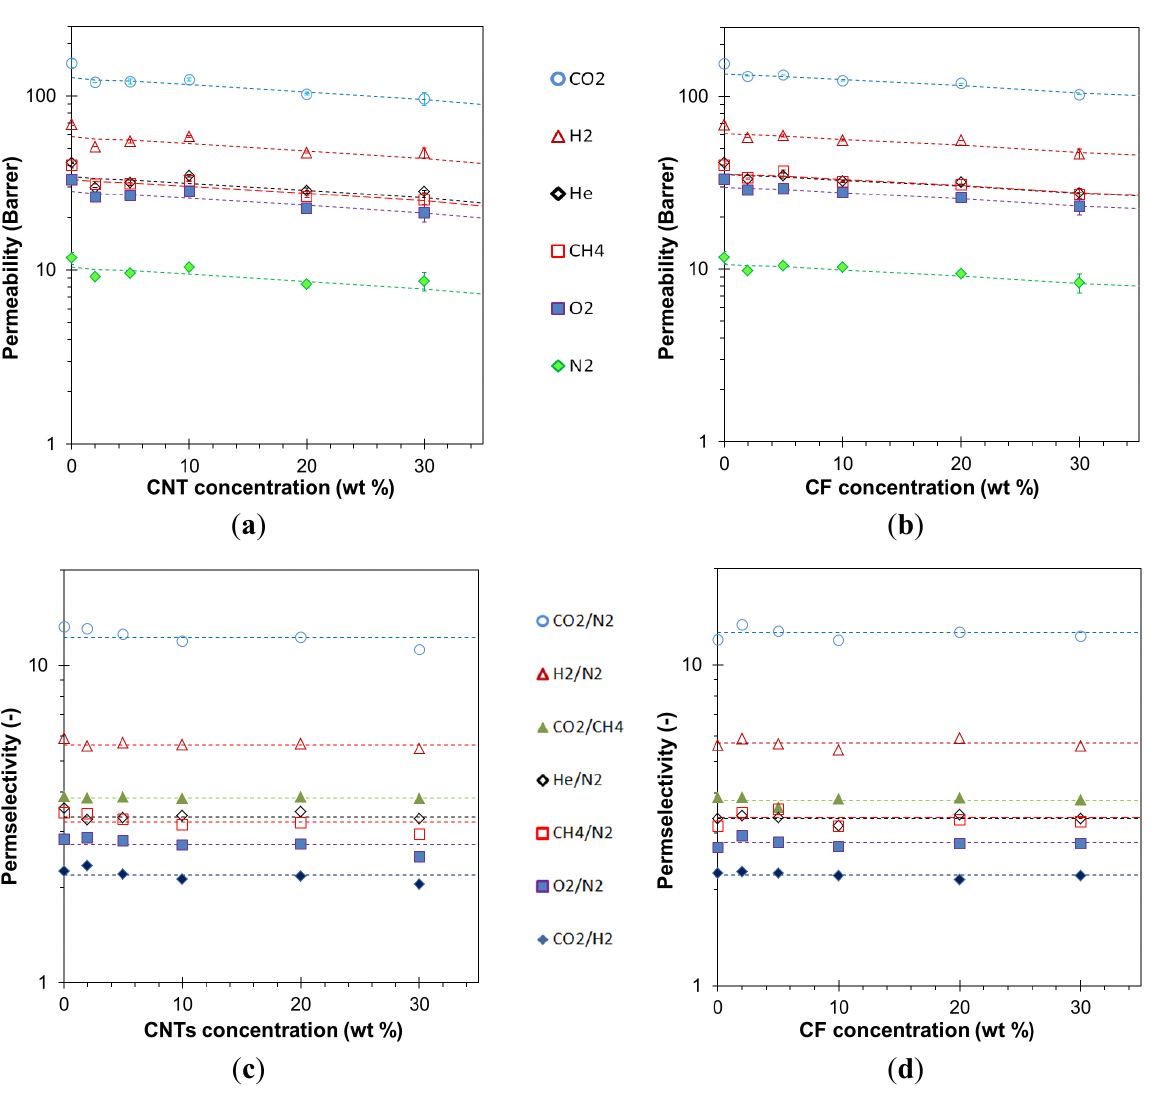
Figure 7. Gas permeability and corresponding ideal permselectivity for EOC/CNTs films ( a , c ) and EOC/CFs composite films ( b , d ) as a function of the carbon filler concentration. The spread in the data of repeated measurements is of the same order of magnitude as the symbol size. Lines in the permeability graphs correspond to the least squares fit of the experimental data with the Maxwell equation (Equation (6)). The lines in the selectivity graphs correspond to the calculated ratio of the fitted